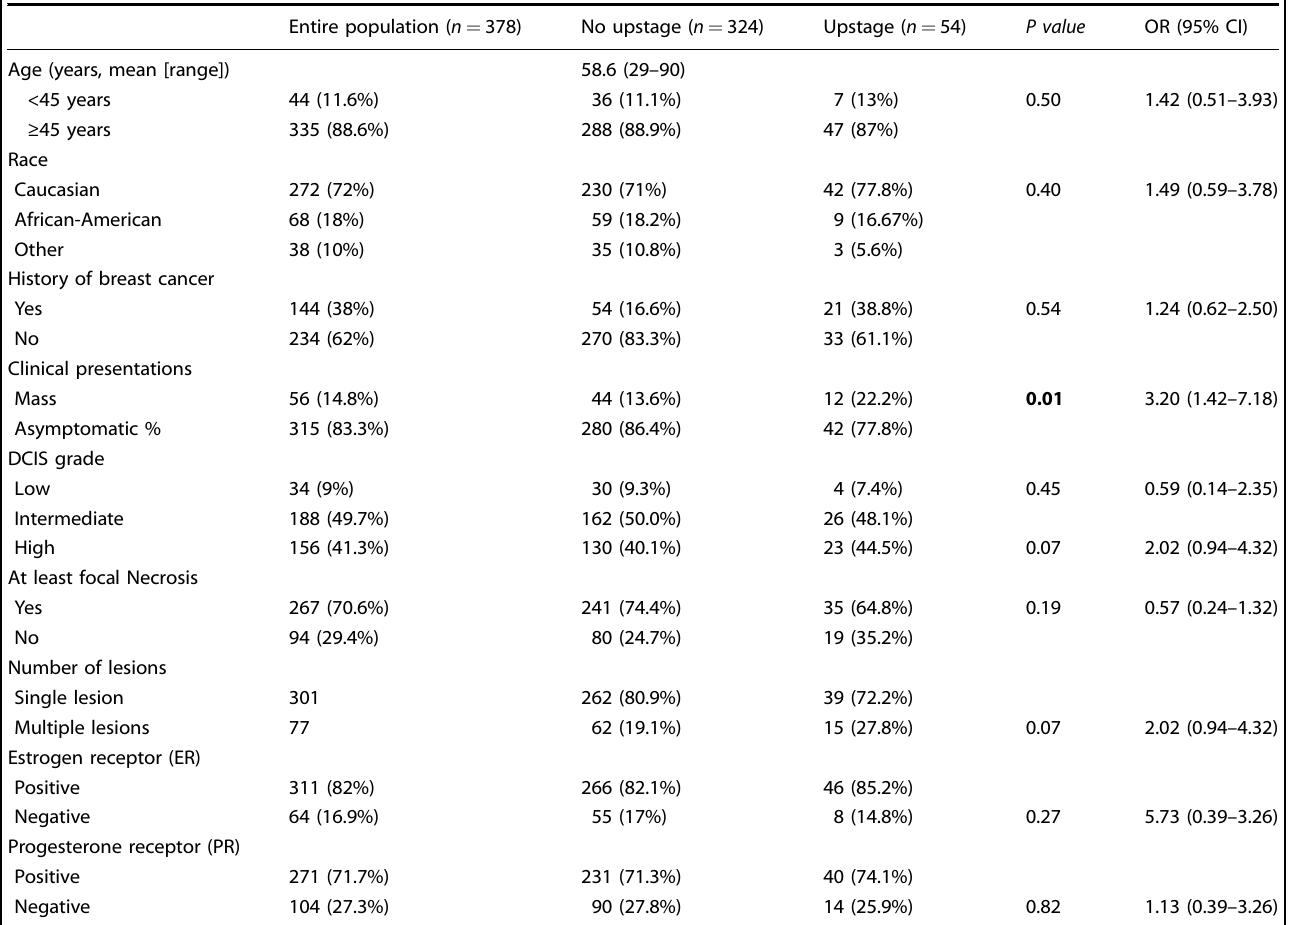
Table 1. Clinical and pathological characteristics of patients diagnosed with DCIS on biopsy and parameters associated with upstaging to invasive cancer at